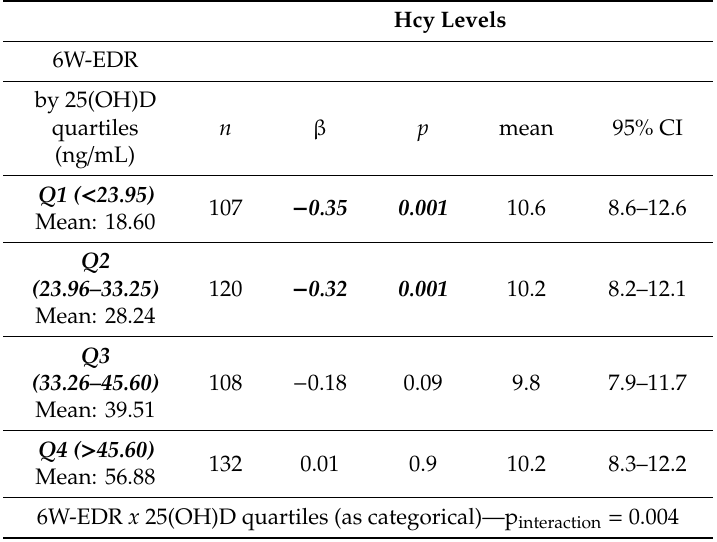
Table 4. Association between 6W-EDR and Hcy levels stratified by quartiles of 25(OH)D levels. Hcy